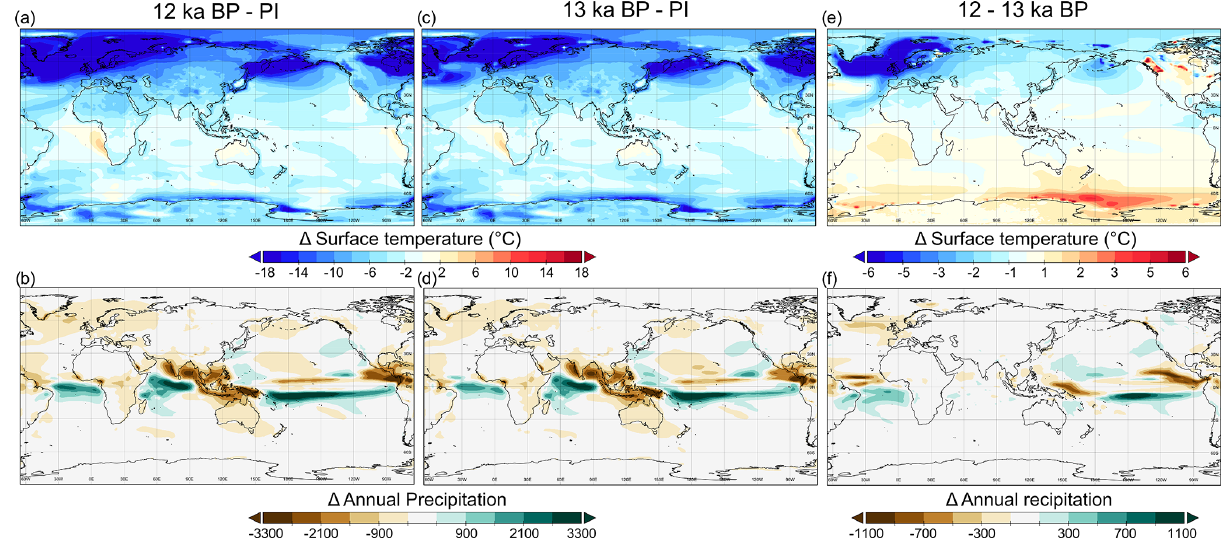
Figure 8. Comparison of preindustrial, 12 and 13kaBP climate states simulated by CESM1. The upper and lower rows show changes in temperature and precipitation, respectively. (a) – (d) show that the changes between 12 and 13kaBP relative to PI are very similar in the tropics. (e) and (f) show changes between 12 and 13kaBP which most notably consist of NH cooling, and SH warming, and that tropical Pacific precipitation patterns are